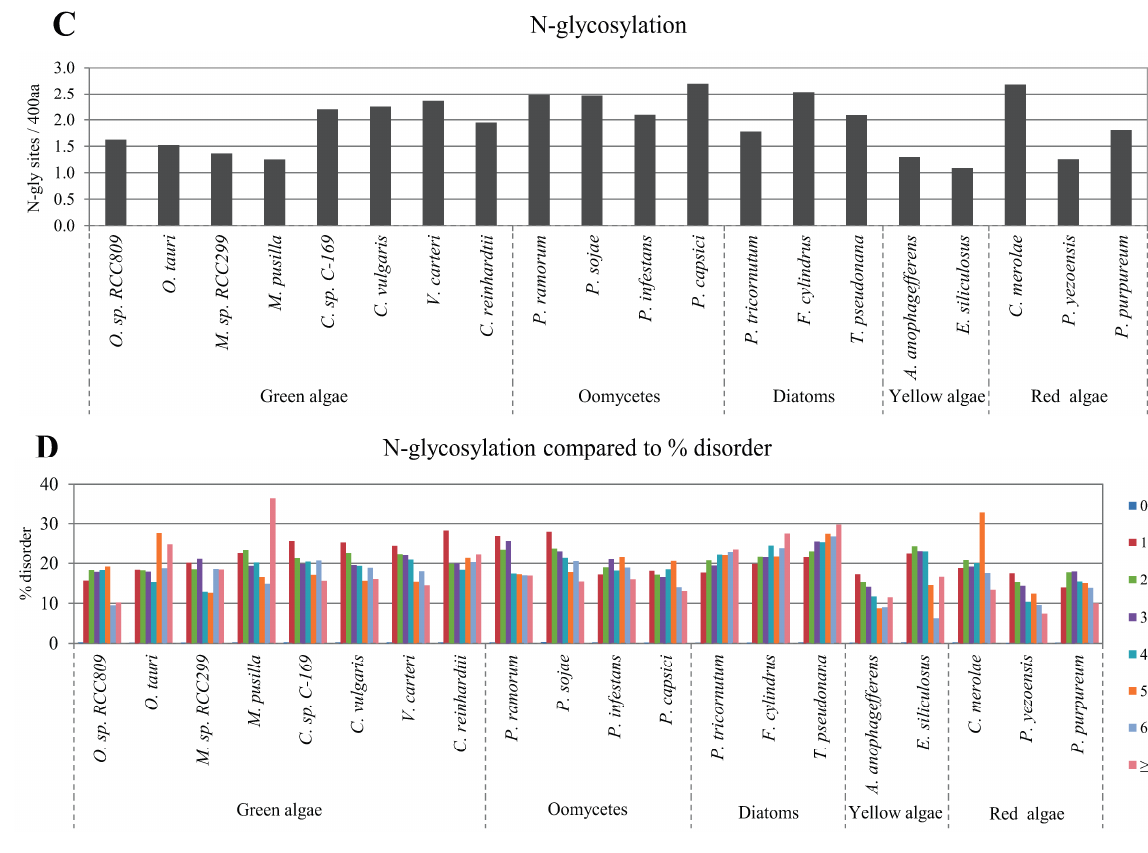
Figure 3. Correlation between disordered protein content and glycosylation sites. Normalized predicted O-glycosylation and N-glycosylation sites per 400 amino acids in the studied algae proteomes are presented in ( A , C ), respectively; The relative percentage of disordered protein content with different numbers of predicted O- and N-glycosylation